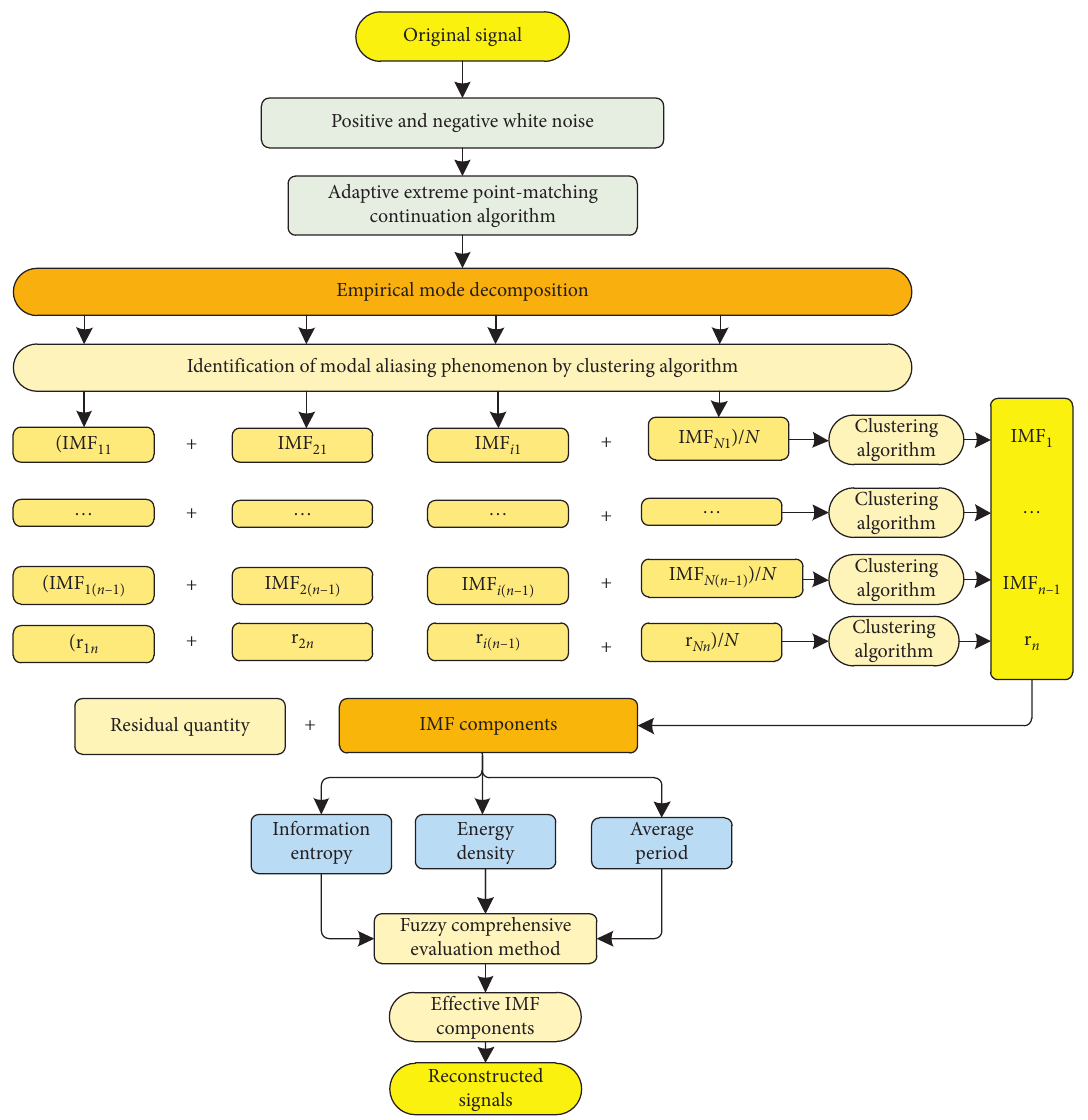
Figure 2: Flowchart of improved